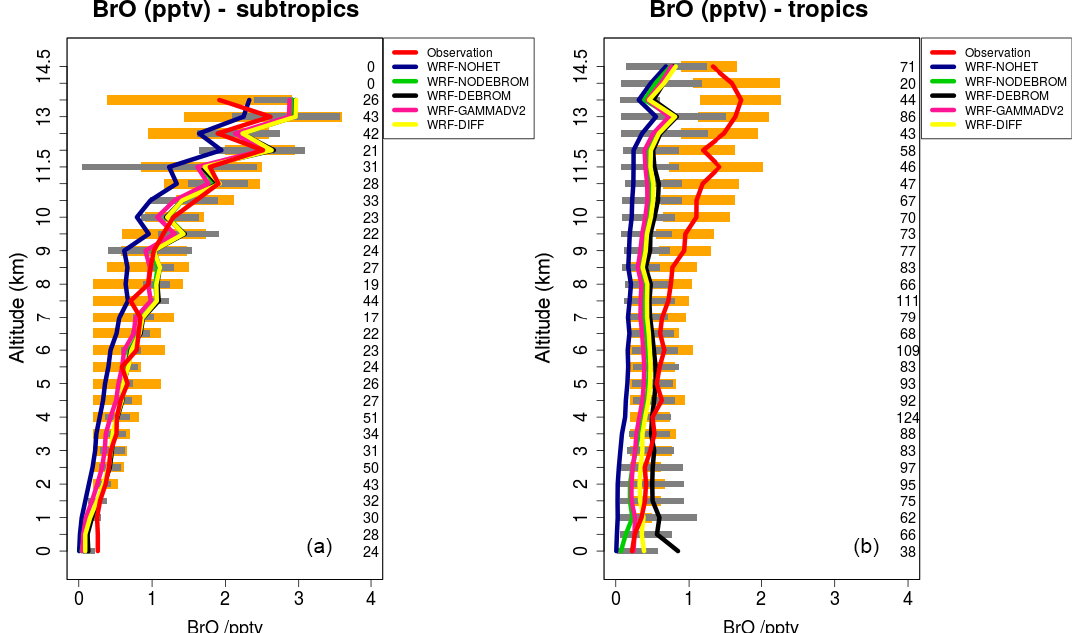
Figure 7. Mean vertical profile of BrO (pptv) over the subtropics (a) and tropics (b) . An average over 16 flights of the TORERO campaign (red line) are compared to the five different WRF-Chem simulations: WRF-NOHET (blue line), WRF-NODEBROM (green line), WRF- DEBROM (black line), WRF-GAMMADV2 (pink line) and WRF-DIFF (yellow line). Orange and grey horizontal bars indicate the 25th– 75th quartile interval for the observations of the TORERO campaign and WRF-DEBROM simulation, respectively. Values are considered in 0.5km bins and the number of aircraft measurement points for each altitude is given on the right side of each